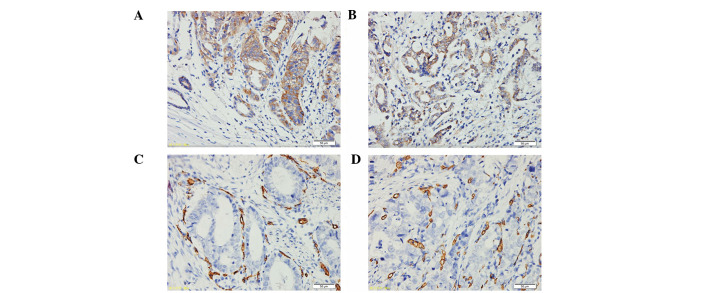
Immunohistochemical staining for vascular endothelial growth factor (VEGF) is predominantly observed in the cytoplasm of lung cancer cells. (A) Strong positive expression of VEGF was observed in the moderately differentiated adenocarcinoma. (B) Positive expression of VEGF was observed in the moderately differentiated squamous carcinoma and CD34 staining was predominantly located in the surrounding microvessels of the lung carcinoma. Positive expression of CD34 was observed in the moderately differentiated (C) adenocarcinoma and (D) squamous carcinoma (streptavidin-peroxidase; scale bar, 50 μm; magnification, ×200).